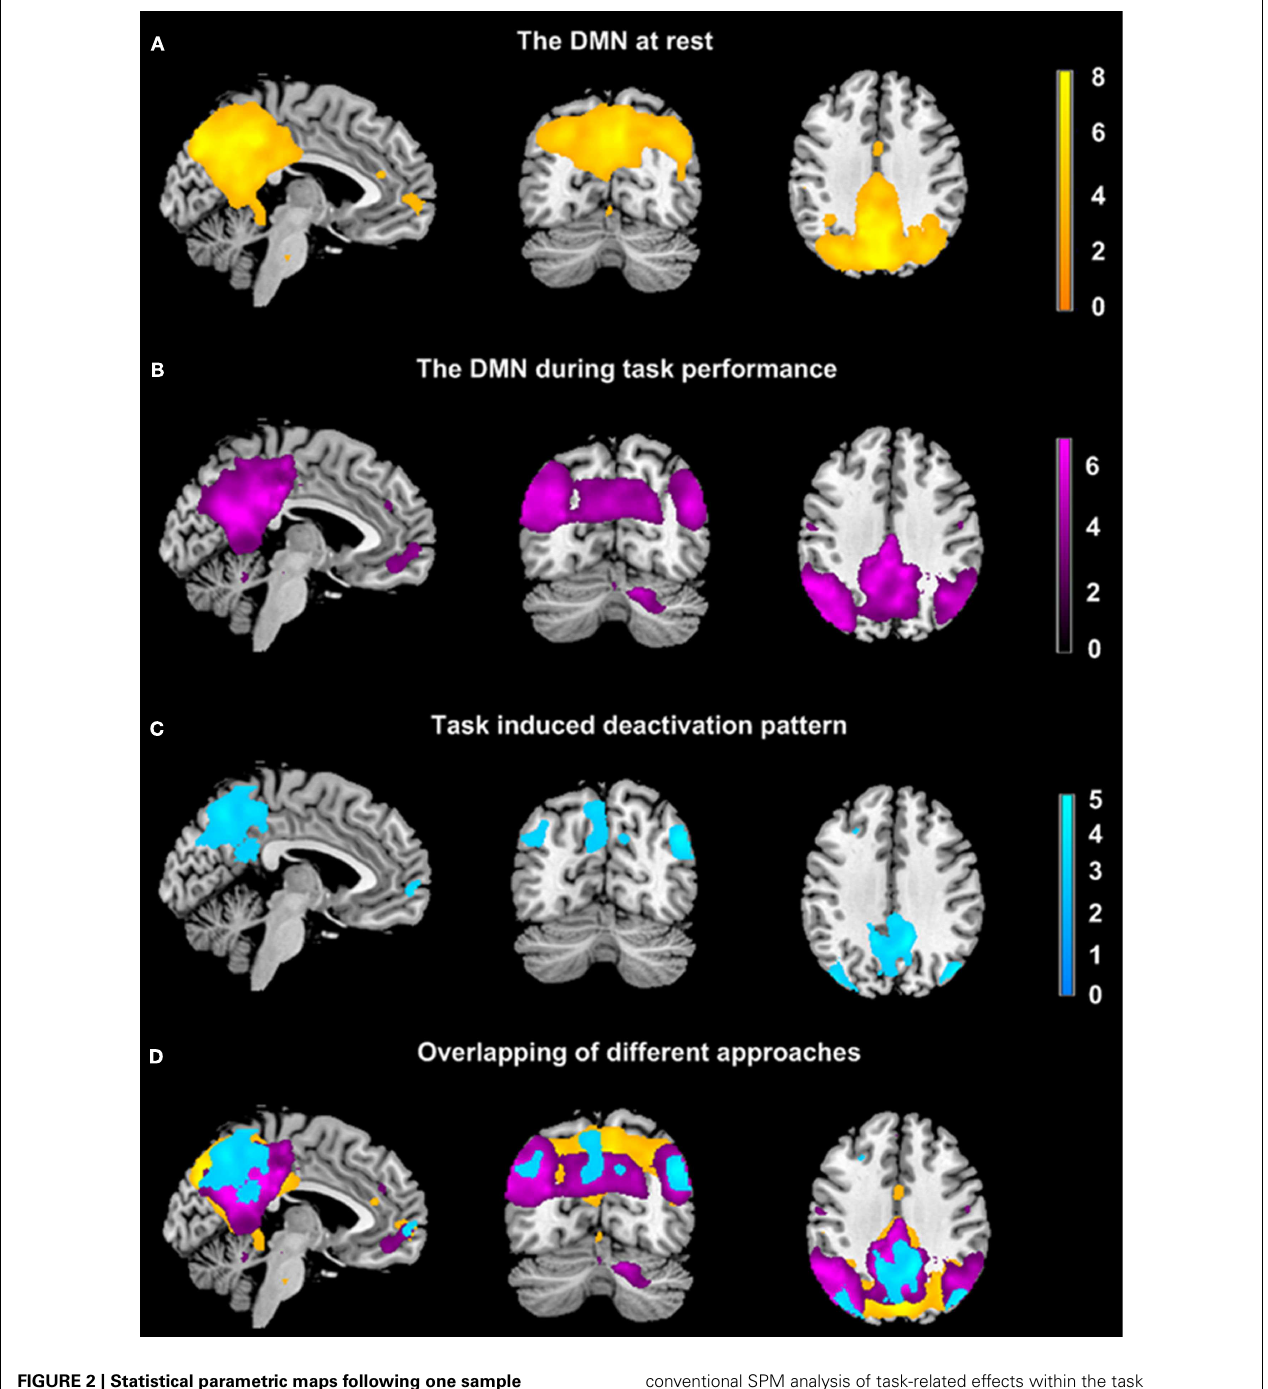
FIGURE 2 | Statistical parametric maps following one sample t -tests on the default mode components over subjects (thresholded at p < 0.005 uncorrected). The upper rows show the default mode component at rest (A) and during the task session (B) . (C) Shows the task-induced deactivations, detected using a